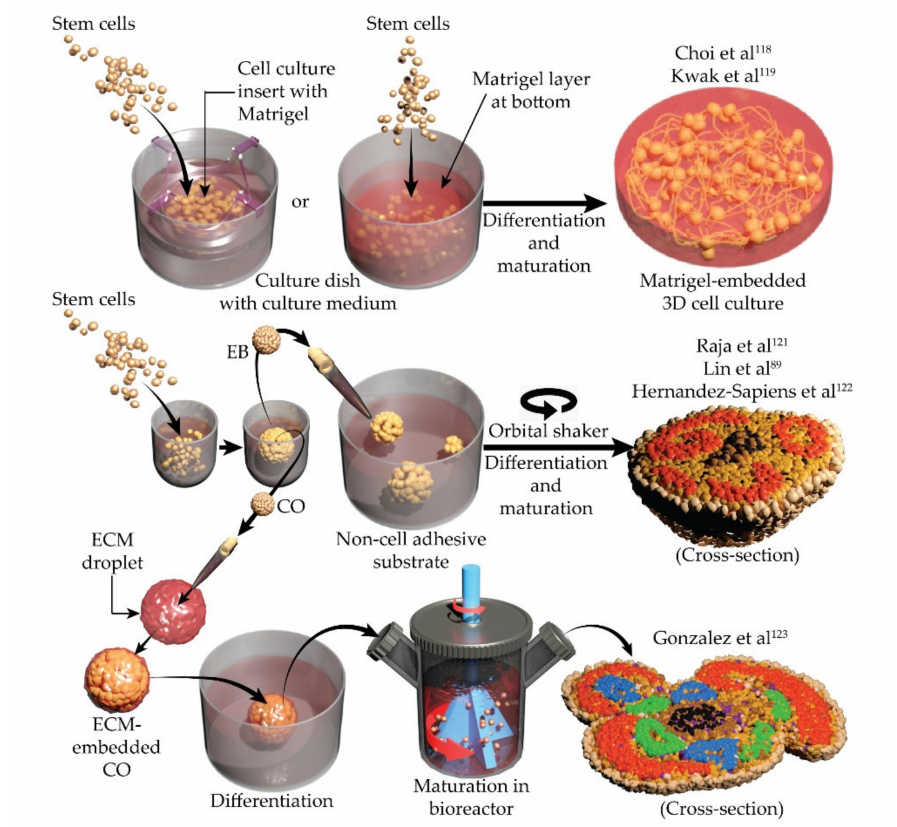
Figure 2. Simplified description of processes used to create 3D cultures for modeling Alzheimer’s disease in vitro [89,118,119,121,123]. CO, cerebral organoid; EB, embryoid body; ECM, extracellular matrix; 3D,